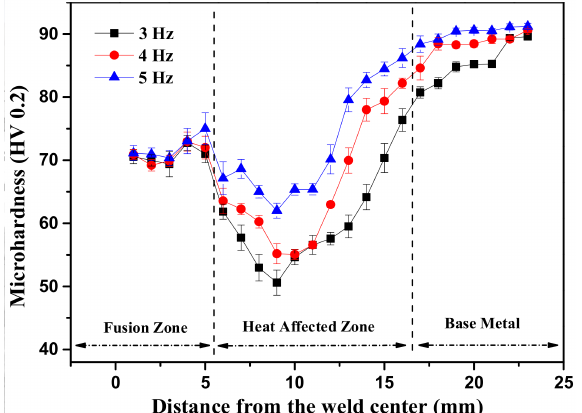
Figure 9. Microhardness distribution in welded joints.